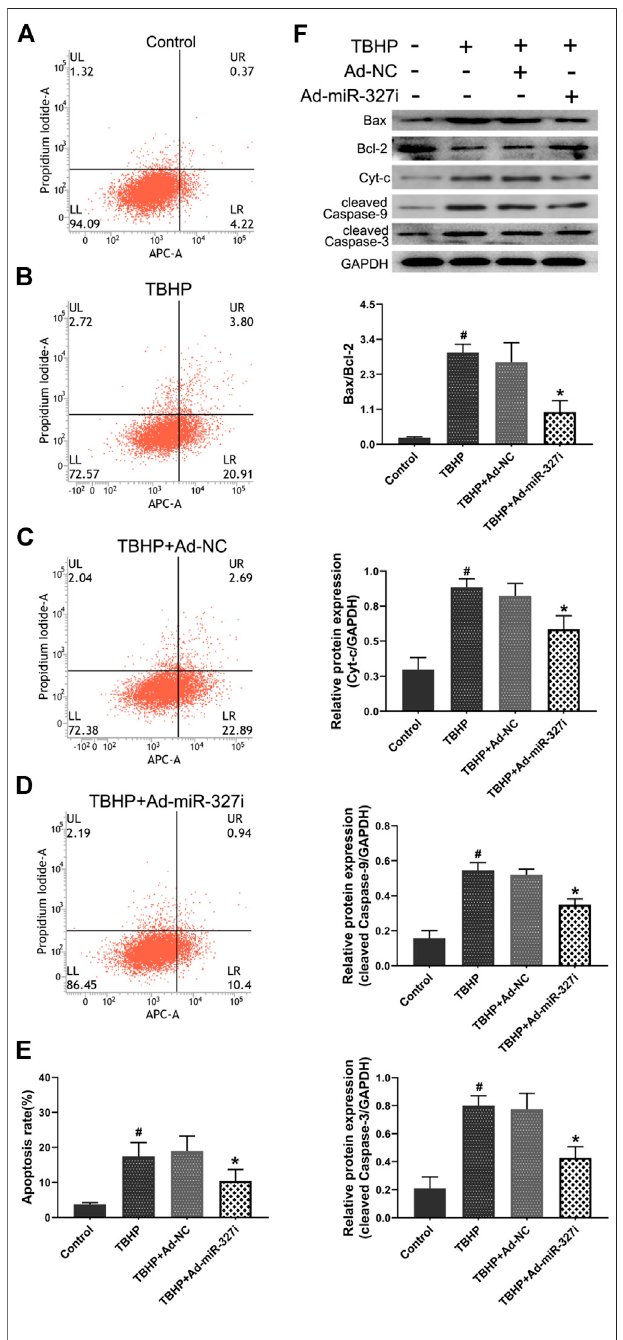
FIGURE6| Effects ofdownregulationofmiR-327 on apoptosis inTBHP treated H9c2 cells. The AV-APC/PI double-staining assay was performed to detect apoptosis in H9c2 cells after TBHP treatment (A-D) , and the relative apoptotic indexes in each group were expressed in bar graphs (E) . Apoptosis-related protein Bax, Bcl-2, Cyt-c, cleaved caspase-9, and cleaved caspase-3 expression levels were detected by the Western blot analysis in H9c2 cells (F) . Dataareexpressed asthemean ± SD ( n (cid:2) 3); # p < 0.05 versus the Control group; * p < 0.05 versus the Ad-NC